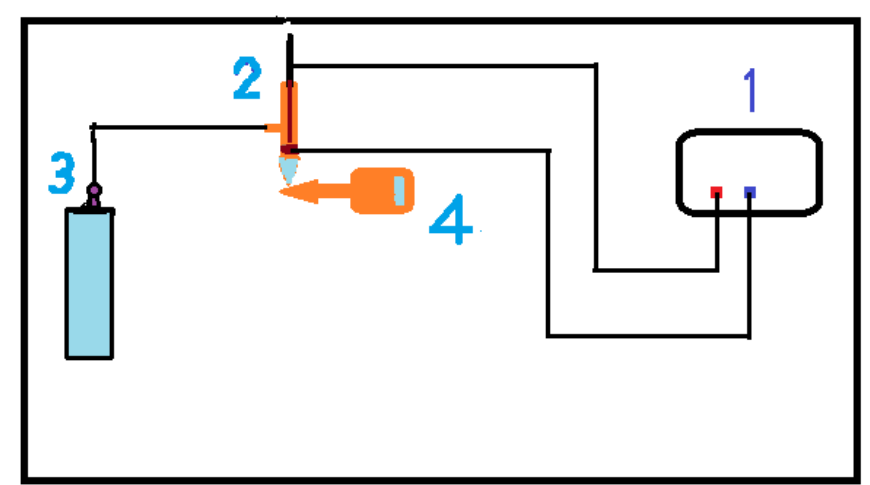
Fig. 3: Schema illustrating non-thermal plasma needle system, where: 1- HV power supply, 2- non-thermal plasma needle, 3- Argon gas, 4- the